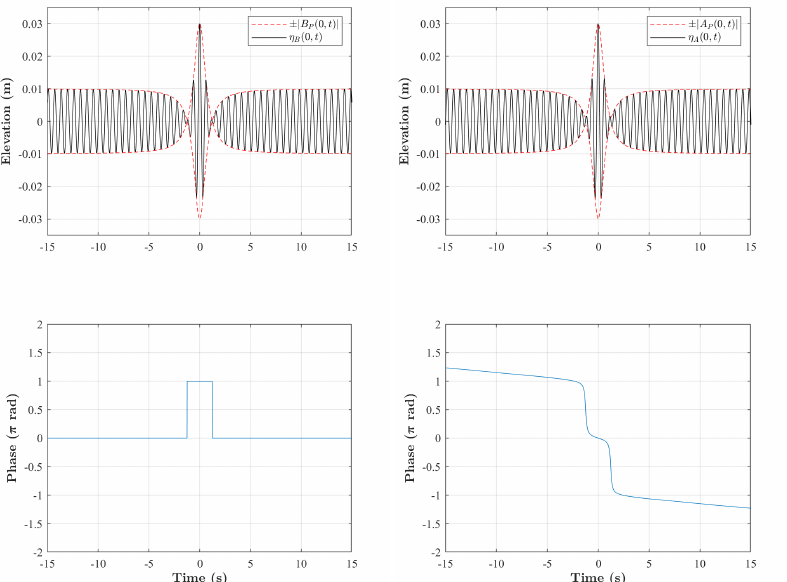
Figure 1. Theoretical temporal surface elevation profiles (solid black lines), wave envelope (dashed red lines) and the corresponding phase (blue lines) of the Peregrine breather at its peak location x = 0 m from time-NLSE ( left ) and space-NLSE ( right ). The steepness adopted is ak = 0.1 and the carrier wave amplitude is a = 0.01 m. Same parameters have been adopted for the following.